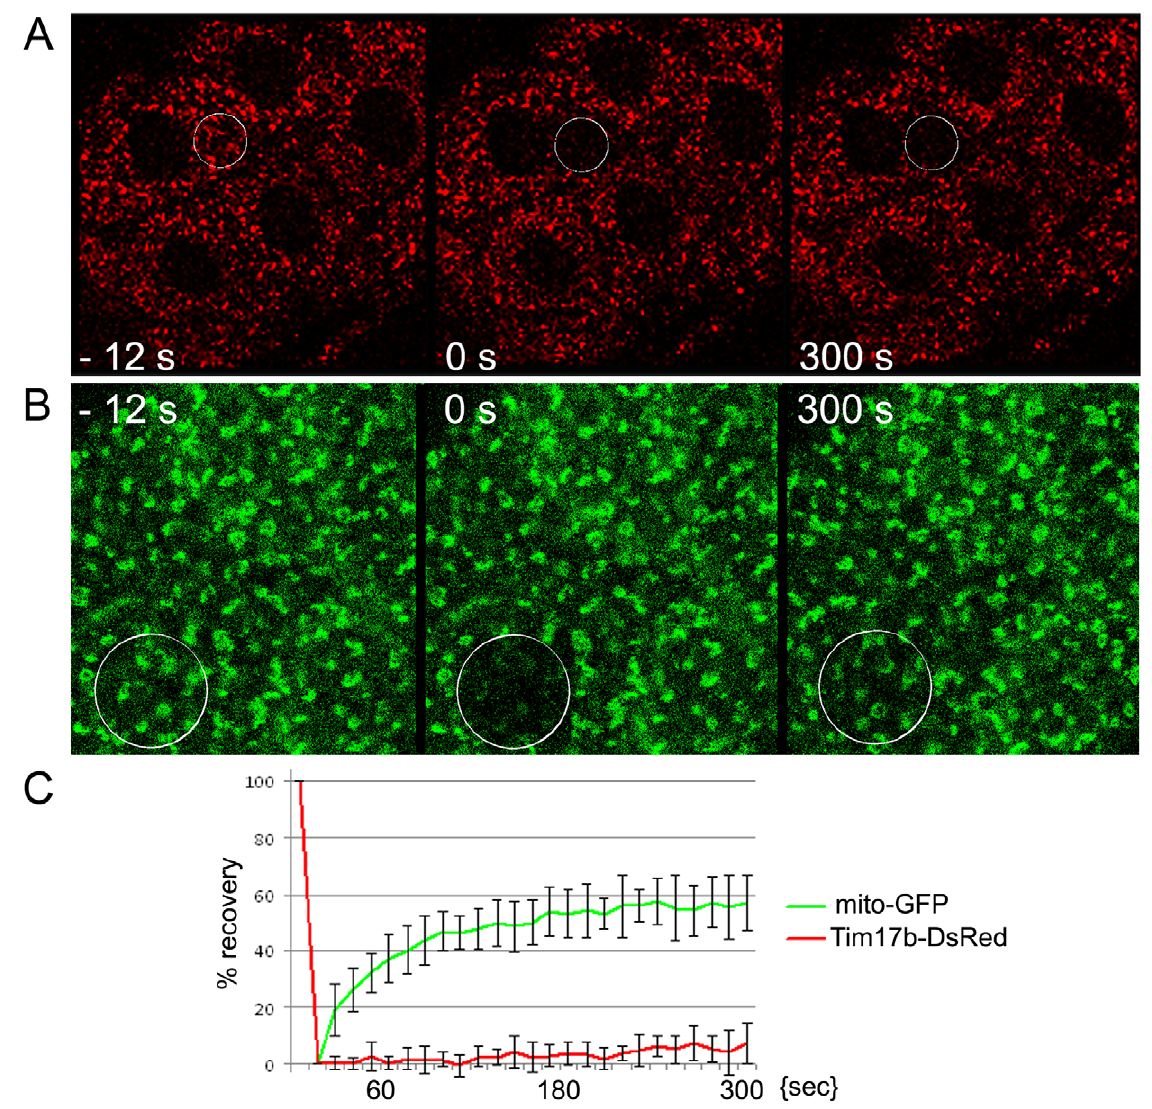
Figure 6. Fluorescence Recovery After Photobleaching (FRAP) assay for Tim17b-DsRed and mito-GFP proteins. A. Tim17b-DsRed (red). B. mito-GFP (green). White circle shows position of photobleached area ( A – B ). In contrast to soluble GFP protein of mitochondrial matrix, assay demonstrates that Tim17b, which is a transmembrane protein, has a very slow replacement/dynamic rate ( C ).